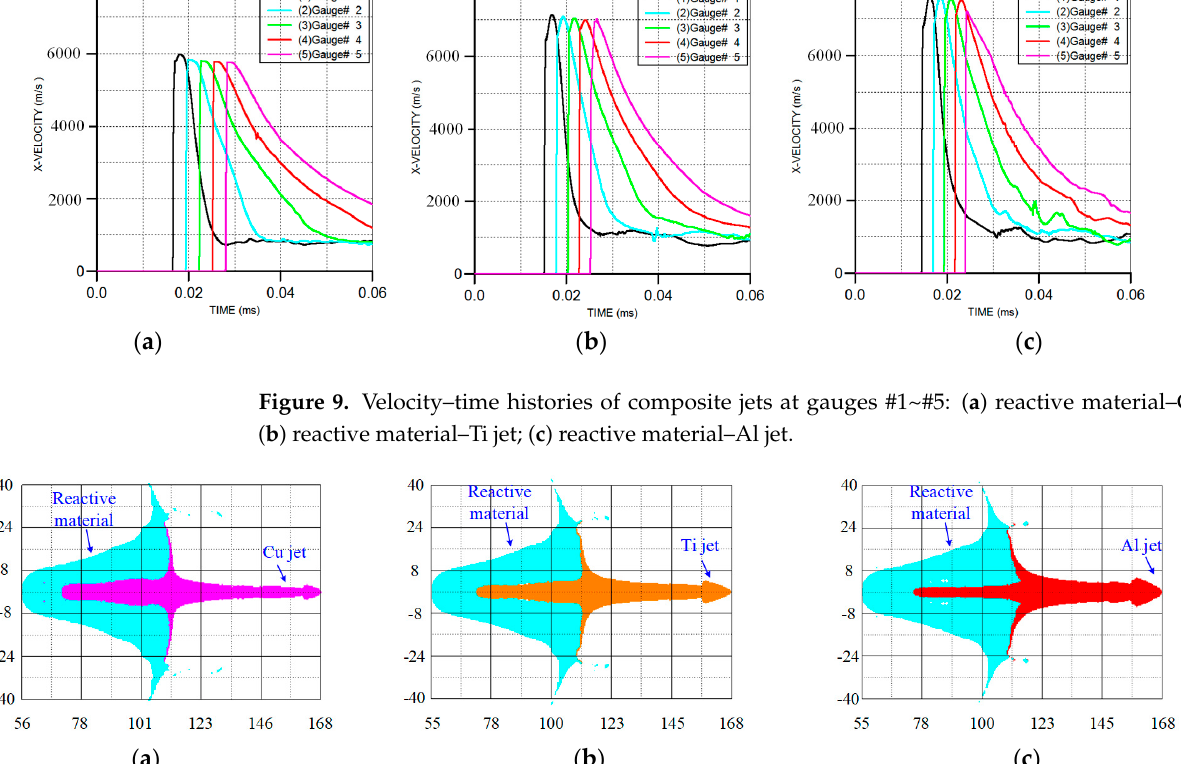
Figure 11. Typical detonation wave propagation and composite jet formation process. According to the simulation results, the performance parameters of the three kinds of reactive material composite jets are listed in Table 5, where v j,1 and v j,5 are the jet velocity at gauges #1 and #5, respectively, d m,j is the maximum diameter of the jet head and L j and L j,m are the whole length of the composite jet and the length of the metal jet, respectively. The numerical results showed that v j,1 and v j,5 increased gradually as the material of the metal liner changed from Cu to Ti and Al. This was mainly because, for the SC with the same structure, the tip velocity of the jet was inversely proportional to the density of the composite liner. Compared with the reactive material–Cu jet velocity ( v j,5-Cu ), the jet velocity values of v j,5-Ti and v j,5-Al increased by 18.2% and 25.1%, respectively. In addition, by comparing the velocity of the reactive material–Ti jet with that of the reactive material– Al jet, v j,1-Al was approximately 7.2% higher than v j,1-Ti , while v j,5-Al was only approximately 5.8% higher than v j,5-Ti . This phenomenon showed that the tip velocity of the reactive material–Al jet was greatly affected by the standoff. Specifically, when the standoff was 1.0 CD, the v j,5-Al decreased by approximately 5.7% compared with v j,1-Al . Table 5. Performance parameters of the three kinds of reactive material composite jets. Materials